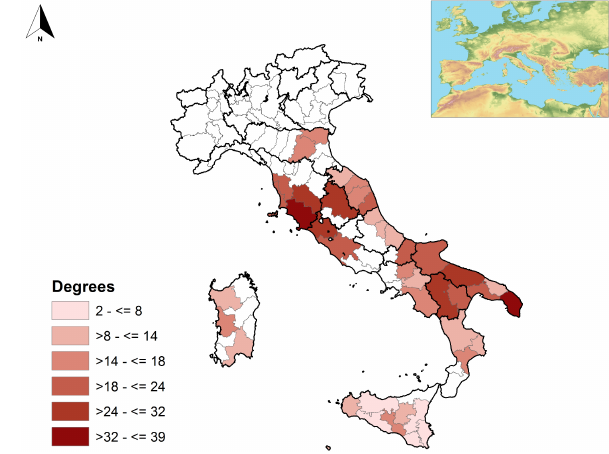
Figure 4. Average intensity of the identified early heat waves in the period